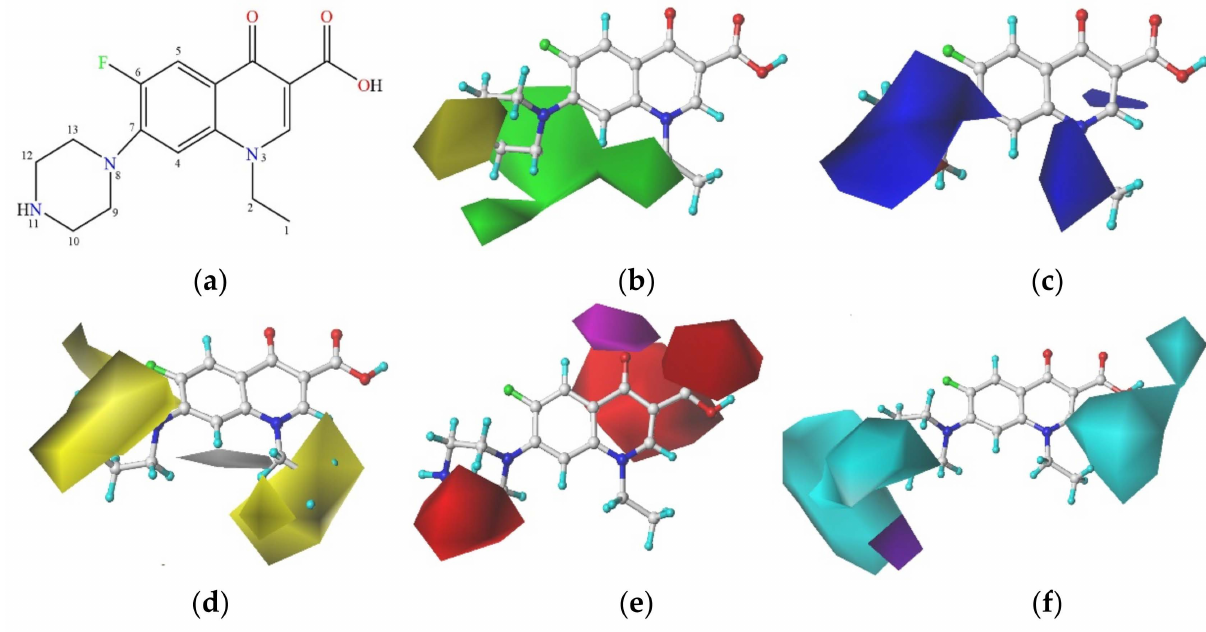
Figure 6. Molecular structure of NOR and the 3D contour map of the CoMSIA model: ( a ) Molecular structure of NOR; ( b ) Steric field; ( c ) Electrostatic field; ( d ) Hydrophobic field; ( e ) Hydrogen bond acceptor field; ( f ) Hydrogen bond donor